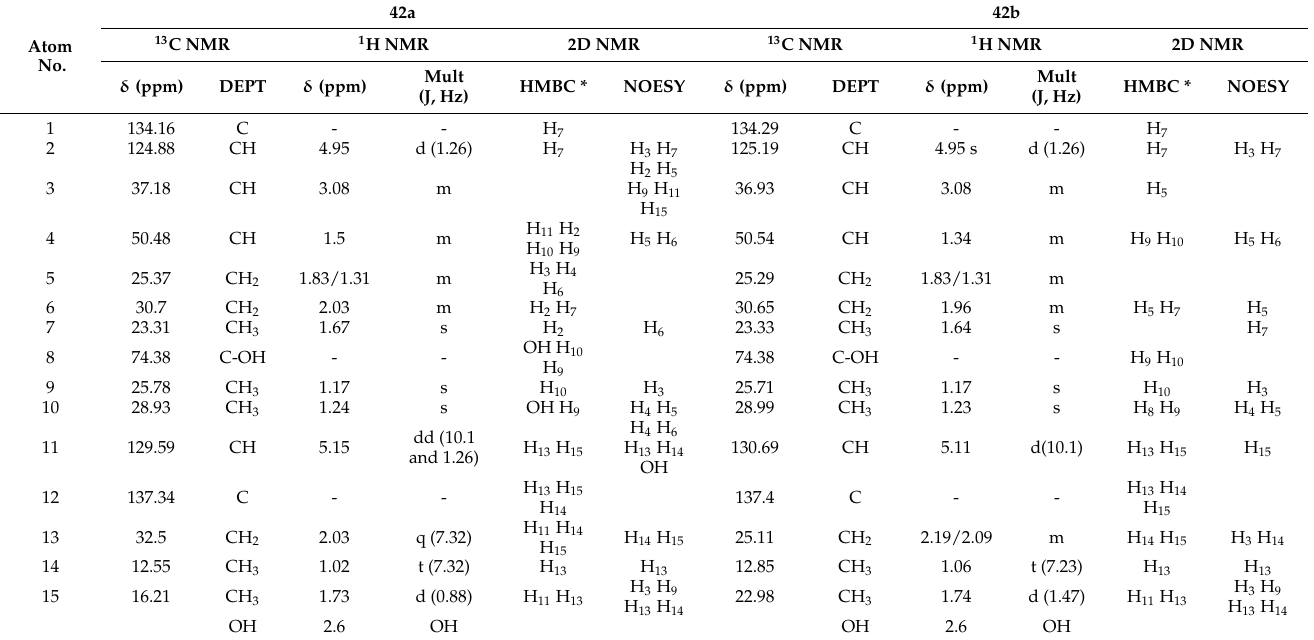
Table 3. Full NMR data of p -menth-1-en-3-[2-methylbut-1-enyl]-8-ol isomers 42a and 42b (in CDCl 3 , at 500 MHz and 300 K) .